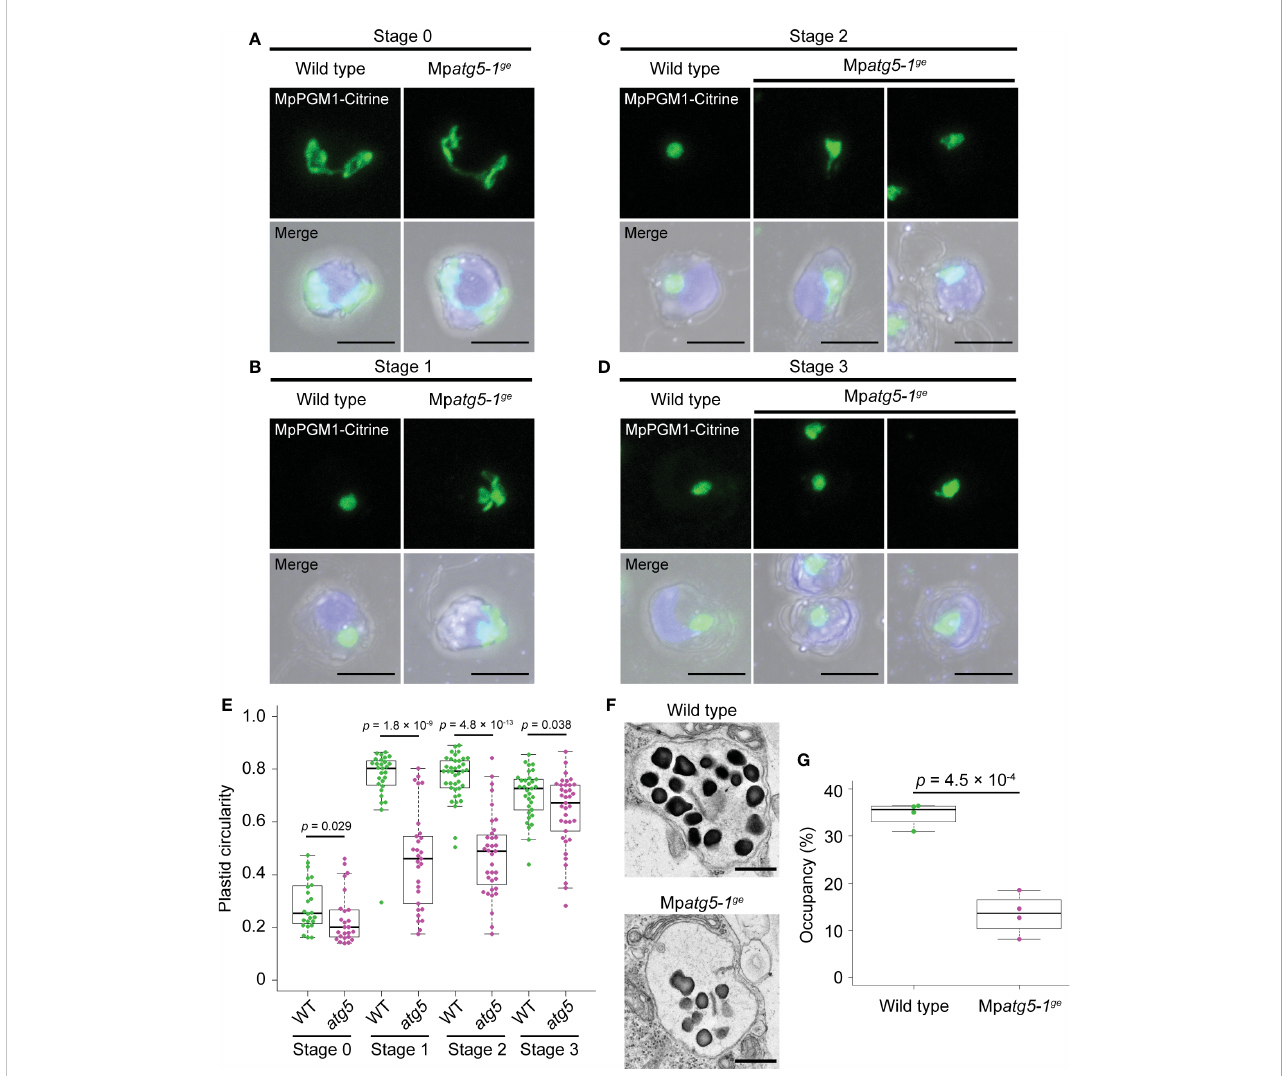
FIGURE 3 Defects in plastid reorganization during spermiogenesis in the autophagy-defective mutant. (A – D) Confocal images of the wild-type and Mp atg5-1 ge antheridial cells expressing MpPGM1-Citrine (green) at stage 0 (A) , 1 (B) , 2 (C) , and 3 (D) . Nuclei were stained with Hoechst 33342 (blue). Scale bars = 5 m m. A total of 24 stage-0, 28 stage-1, 39 stage-2, and 33 stage-3 cells were observed for wild-type antheridial cells, and 25 stage-0, 28 stage-1, 35 stage-2, and 37 stage-3 cells were observed for Mp atg5-1 ge . Representative images are presented. (E) Circularity of the plastid calculated in the same sets of wild-type (WT) and Mp atg5-1 ge ( atg5 ) samples analyzed in (A – D) . (F) TEM observation of the plastids in wild-type and Mp atg5-1 ge spermatids around stage 1-2. Scale bars = 500 nm. Four plastids were observed for each genotype, and representative images are presented. (G) Occupancy of starch granules in plastids. Occupancy indicates the ratio of the total area of the starch granules within a plastid to the area of the plastid. Occupancy was calculated using the same sets of samples analyzed in (F) . For (E) and (G) , the boxes and solid lines in the boxes indicate the fi rst and third quartiles and median, respectively. The upper and lower whiskers are drawn at the greatest value smaller than 1.5× the IQR above the third quartile and the smallest value greater than 1.5× the IQR below the fi rst quartile, respectively. The p values obtained by the Wilcoxon rank-sum test (E) or Welch ’ s t test (G) are